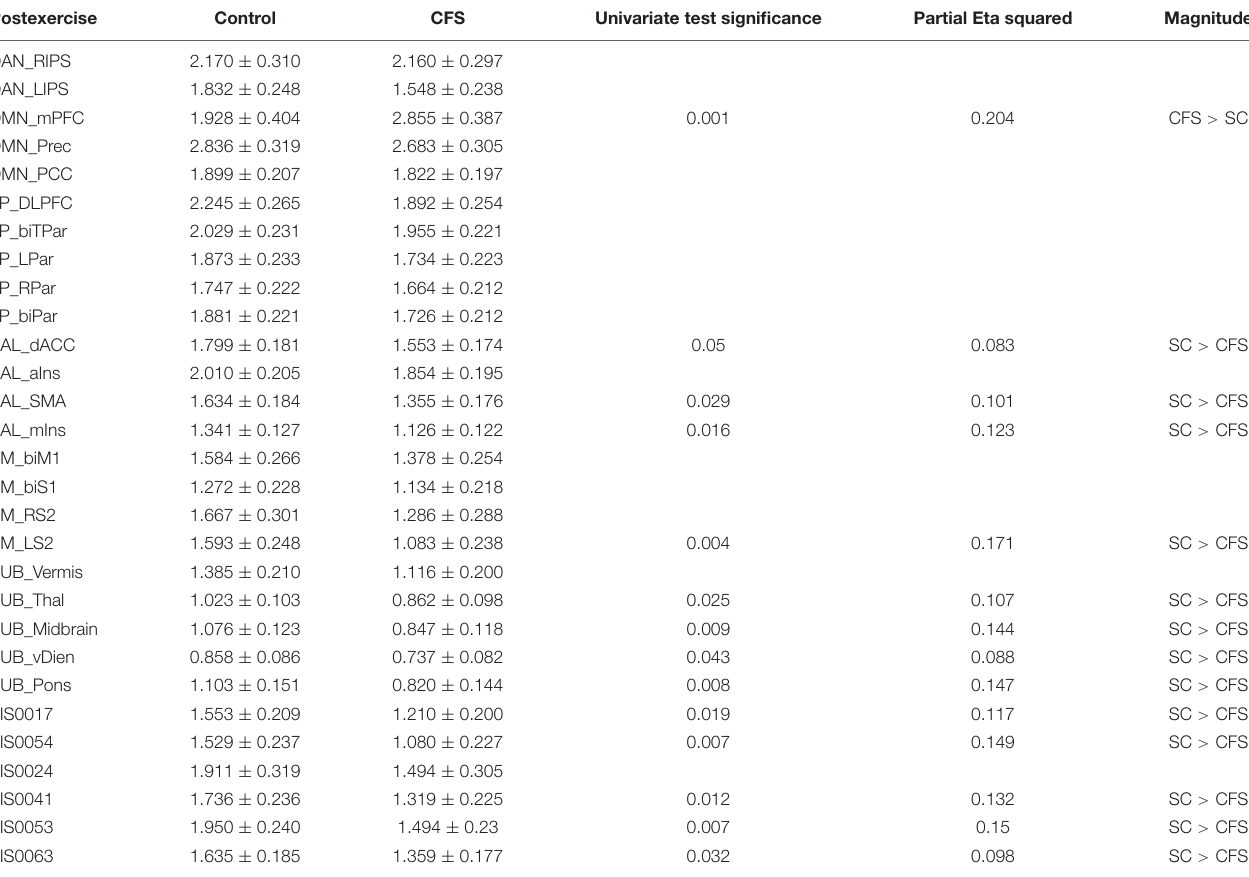
TABLE 4 | Postexercise GLM.